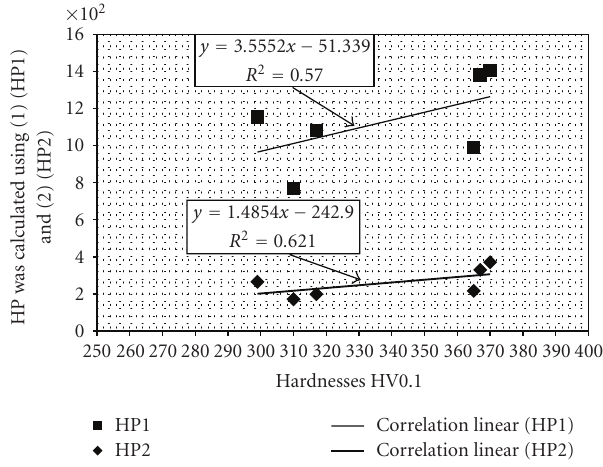
Figure 6: Linear correlation results for superficial hardnesses obtained on quenched 1045 steel. The upper line was obtained for the HP1 versus HV0.1 core hardness correlation and the lower line was obtained for the HP2 versus HV0.1 superficial hardness